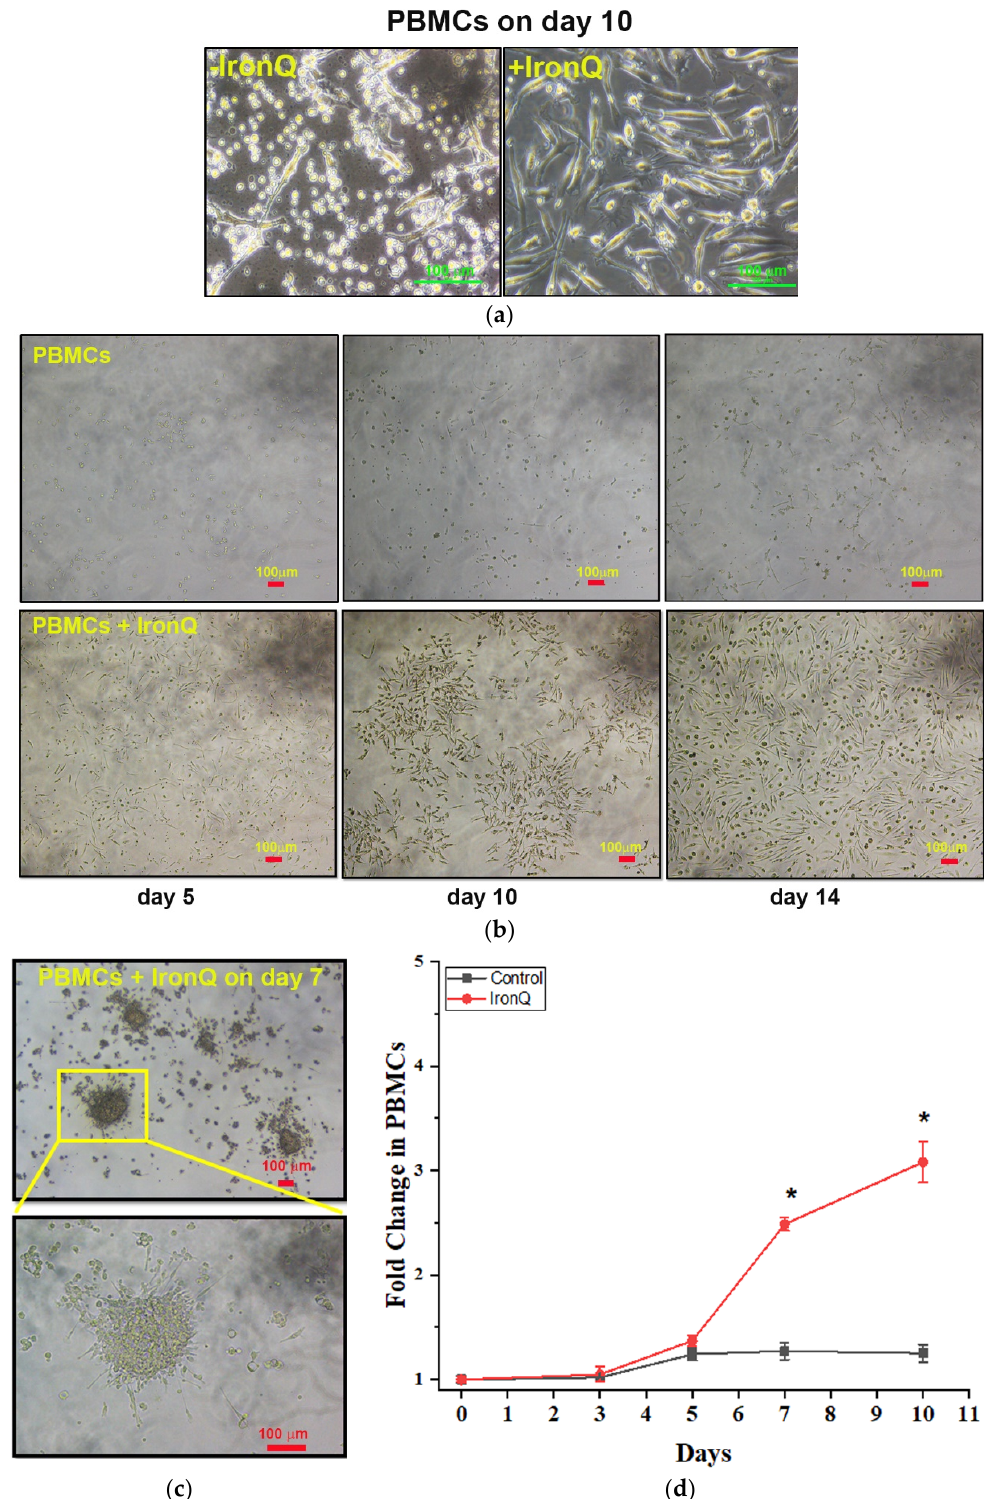
Figure 1. Proliferation and characteristics of the peripheral blood mononuclear cells (PBMCs) treated with the iron-quercetin complex (IronQ). ( a ) Representative phase-contrast images of the morphological states of PBMCs on day 10 of the